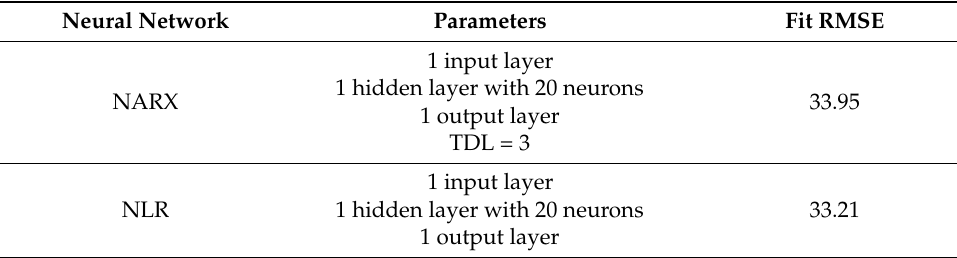
Table 1. Neural network parameters and RMSE for fitted results.